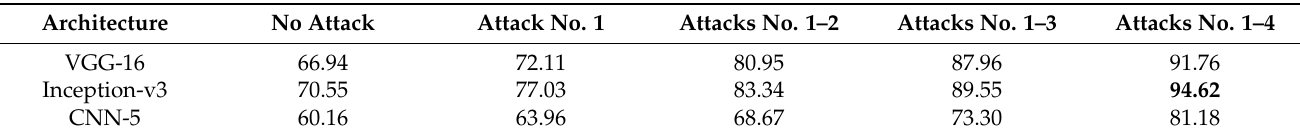
Table 8. Percentage of correct Kaggle.Dogs vs. Cats image recognition with prevention of visual attacks and reduction of imension.